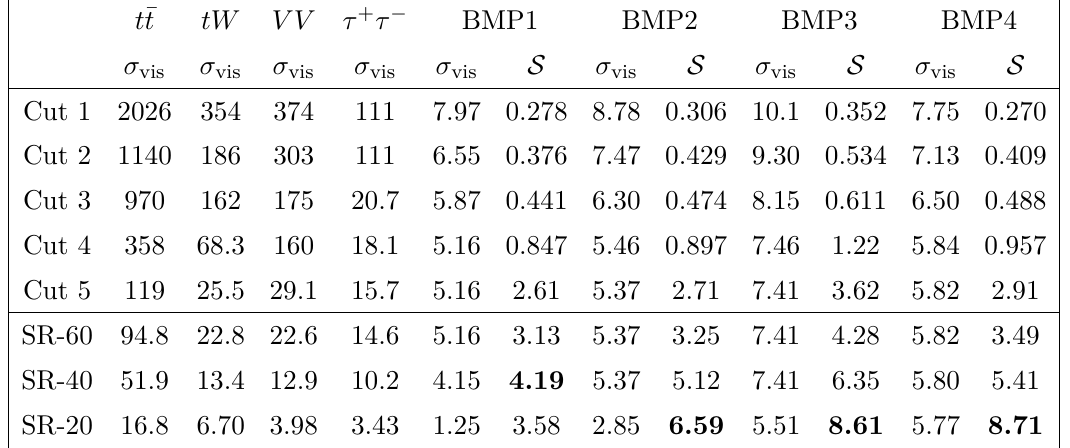
Table 5 . Visible cross section σ vis in fb for the backgrounds and signal BMPs after the cuts and for the signal regions in the soft-dilepton + jets + /E S corresponds to integrated luminosity 3 ab − 1 for β = 1% and γ = 10%